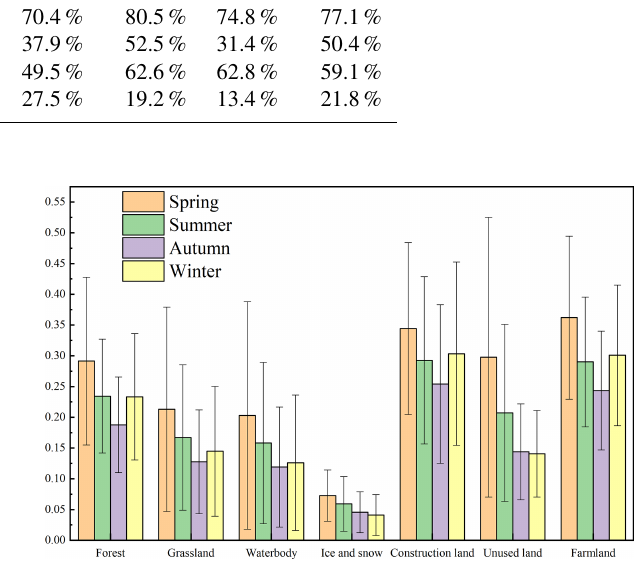
Figure 10. The seasonal AOD distributions over different land cover types. The error bars represent the standard